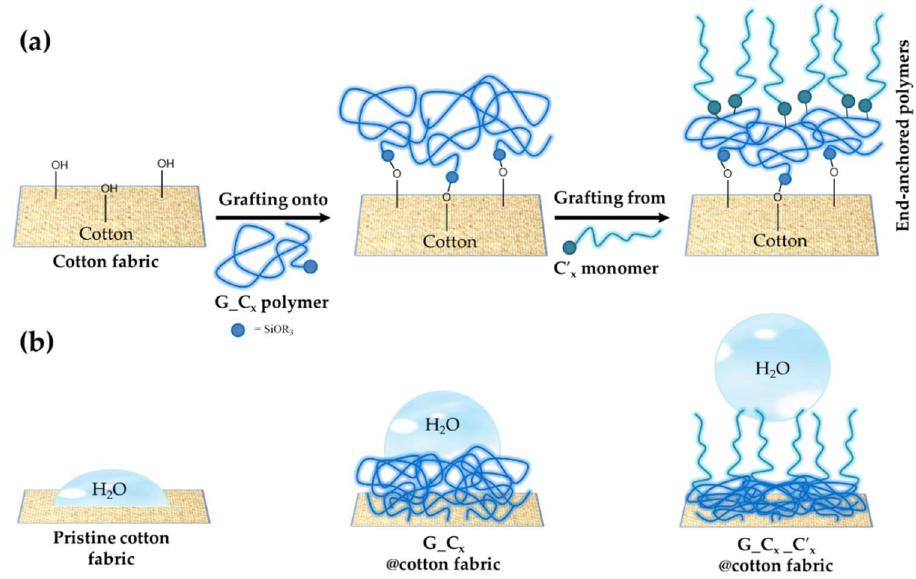
Figure 10. Double surface functionalization of cotton fabrics with alkyl(trialkoxy)silane polymer shell by “grafting to” or “grafting from” covalent grafting techniques ( a ) and corresponding observed surface hydrophobicity of the coated cotton fabrics ( b ).